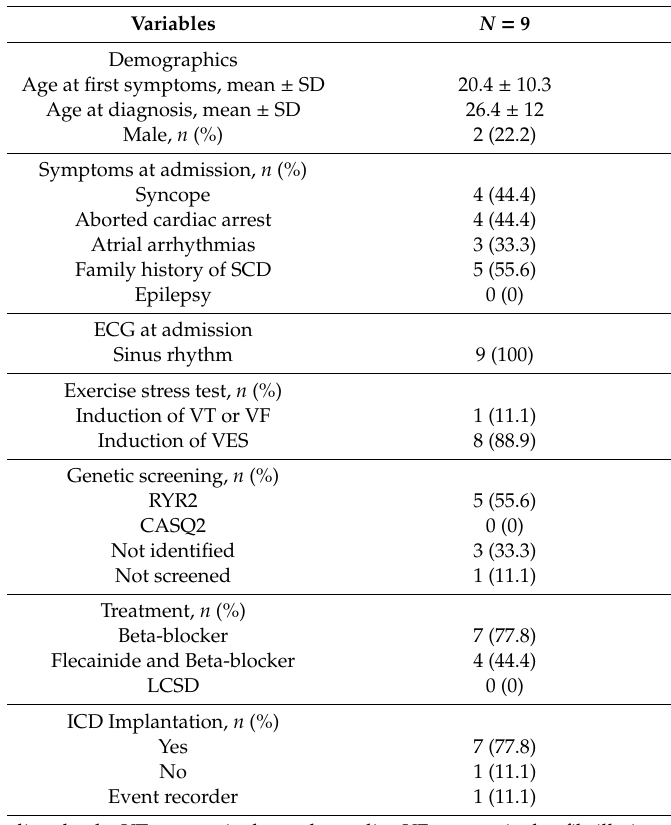
Table 1. Baseline characteristics of catecholaminergic polymorphic ventricular tachycardia (CPVT)